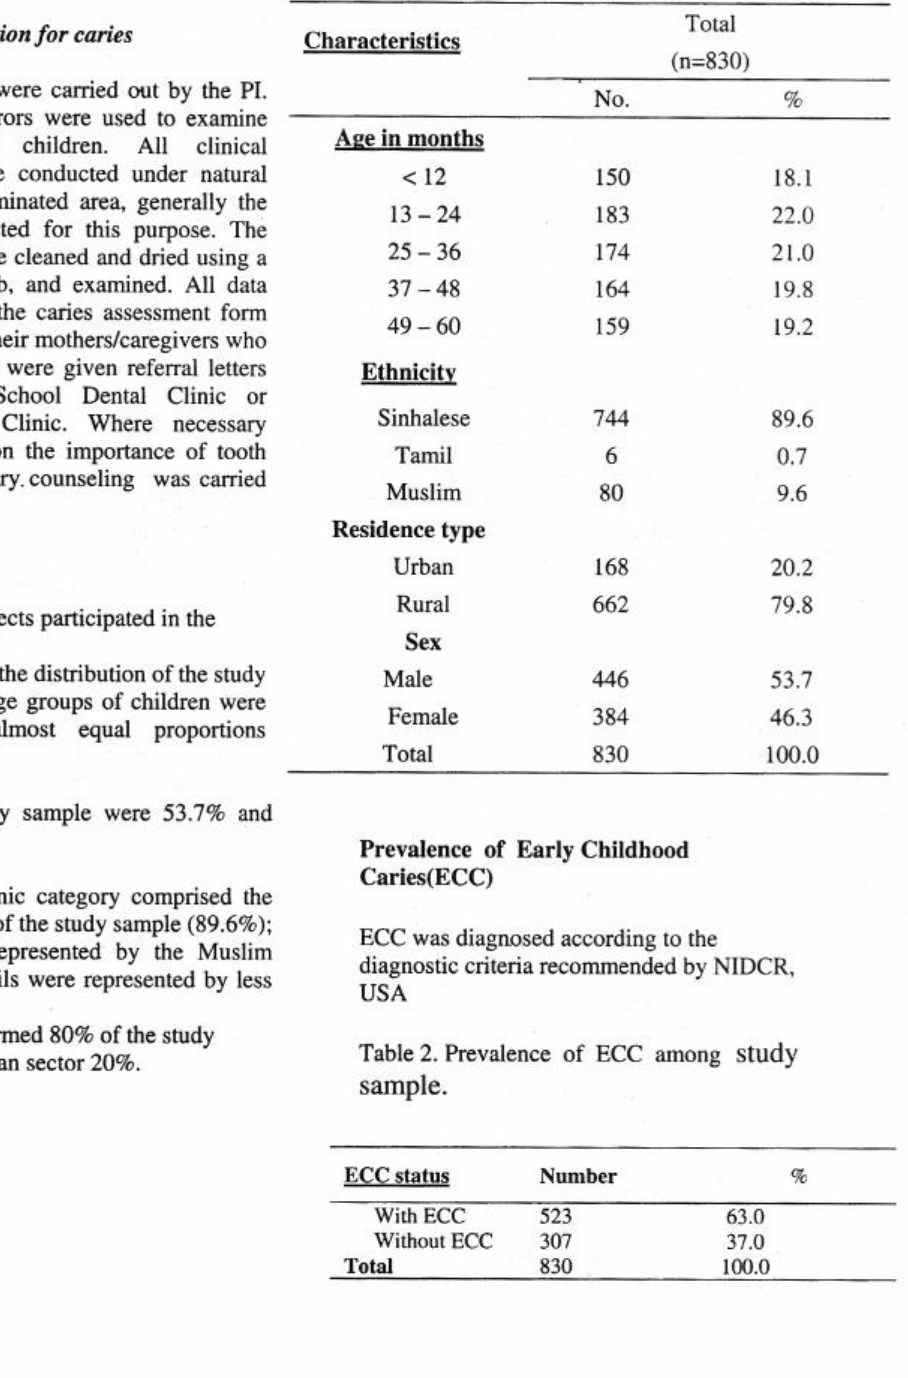
Table 1. Distribution of study sample by